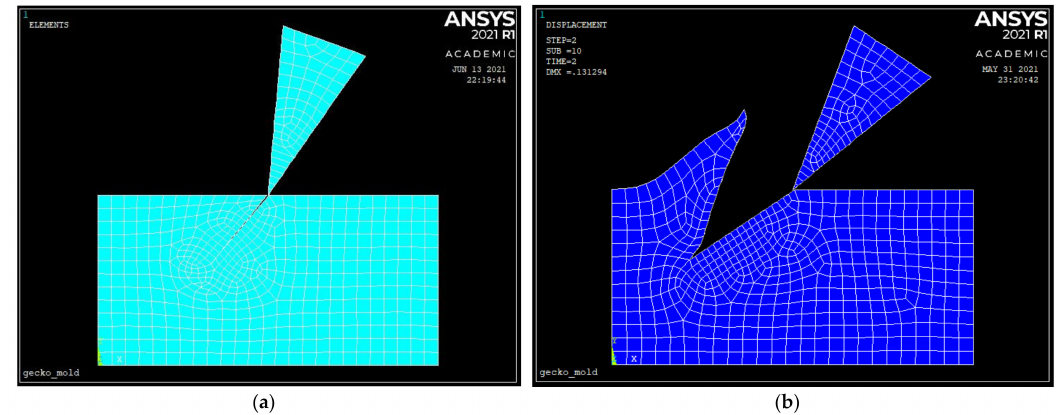
Figure 9. ( a ) Meshing of the workpiece and tool in Ansys, with precut along the cutting trajectory, with inclination λ ’ and depth d. The right and the lower edges of the workpiece are constrained in all the directions; the displacement components are applied to the blade, which is considered rigid. ( b ) Ansys simulation of the formed chip and of the deformed mesh in aluminum with a precut on the workpiece.